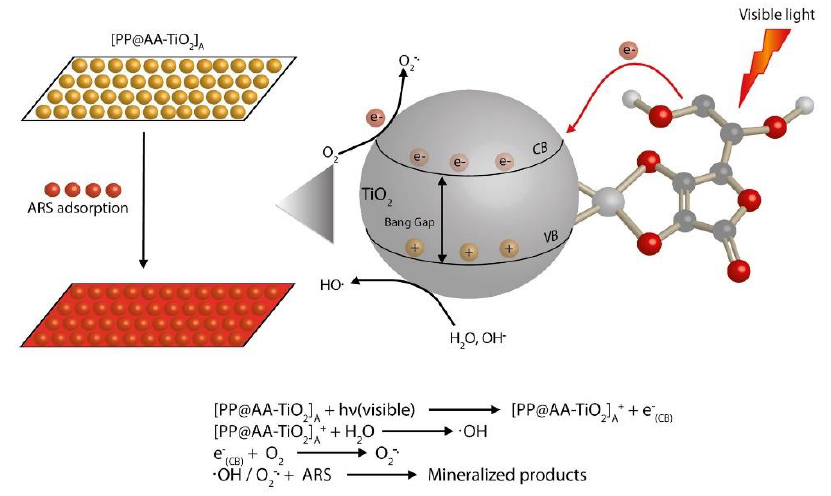
Figure 10. Mechanism of photocatalytic process by using [PP@AA-TiO 2 ] A for the degradation of ARS solution.